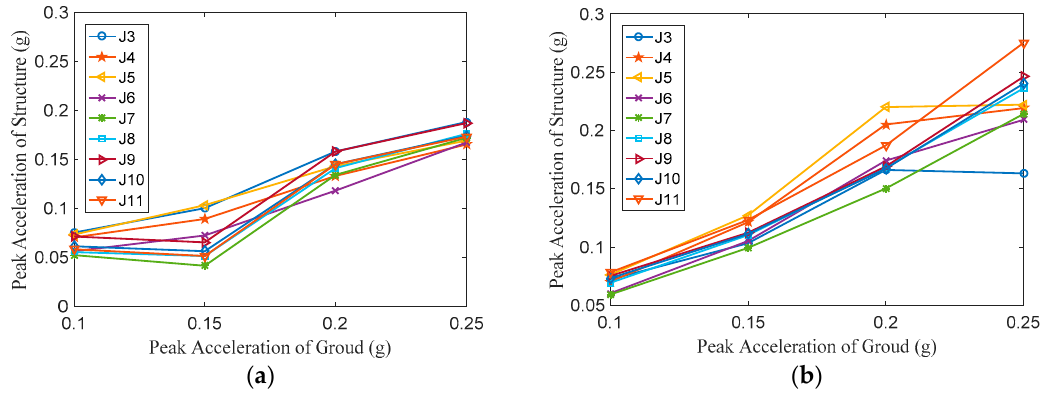
Figure 15. The peak value of the acceleration response for various seismic accelerations. ( a ) API and ( b ) RSN169_IMVPALL.